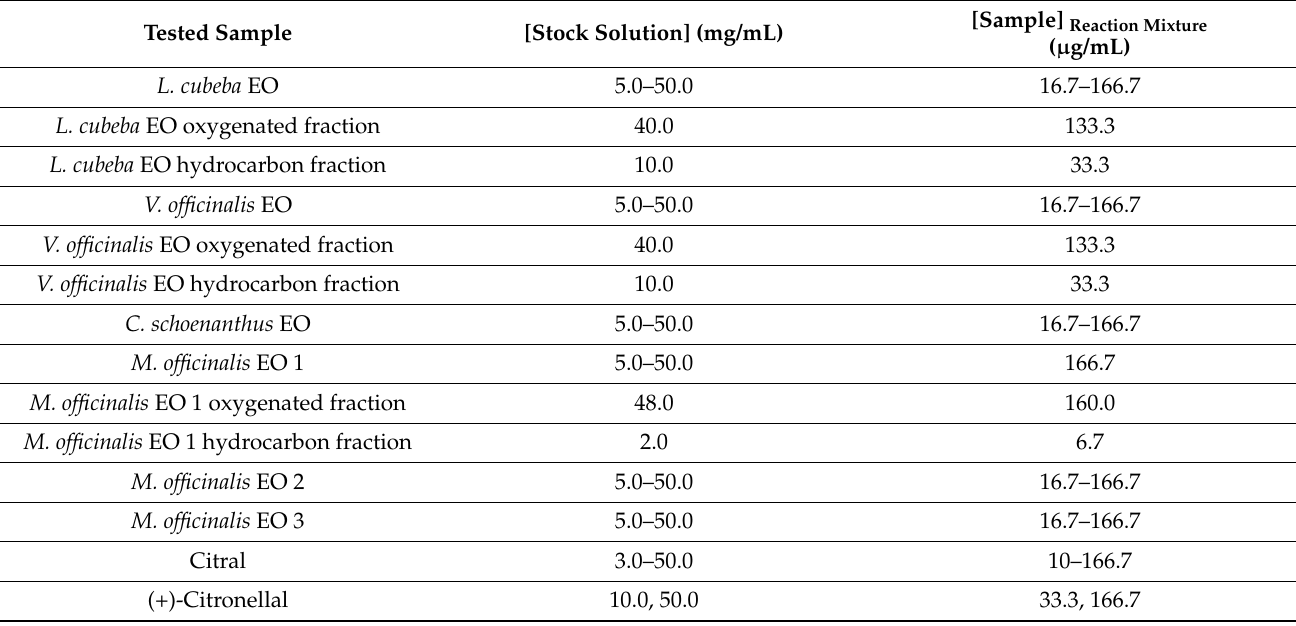
Table 7. Tested concentrations for investigated essential oils and for both the relative isolated hydrocarbon and oxygenated fractions. Tested Sample [Stock Solution]